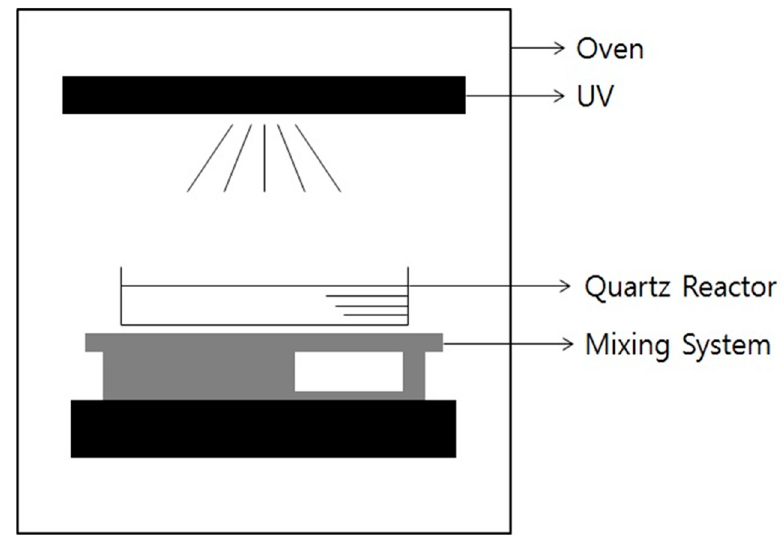
Figure 1. Test equipment for immobilized photocatalyst.